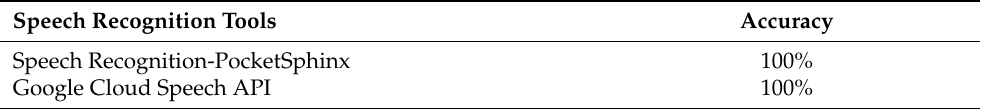
Table 7. The speech recognition accuracy under different speech recognition APIs.